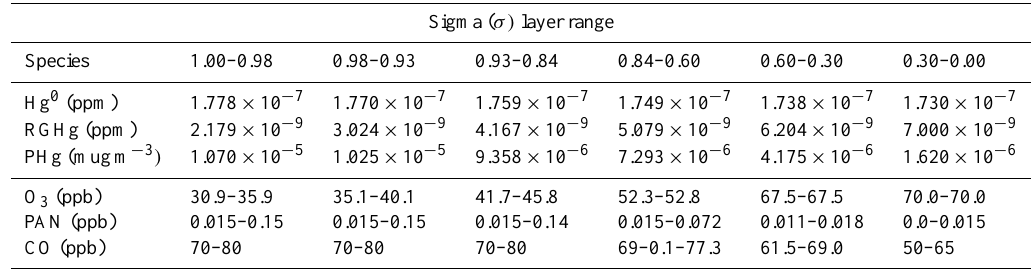
Table A1. Boundary and initial condition values used in CMAQ-Hg for CONUS domain simulation; GLR simulation, which is the basis of all data presented in the text, used boundary values from the CONUS domain.